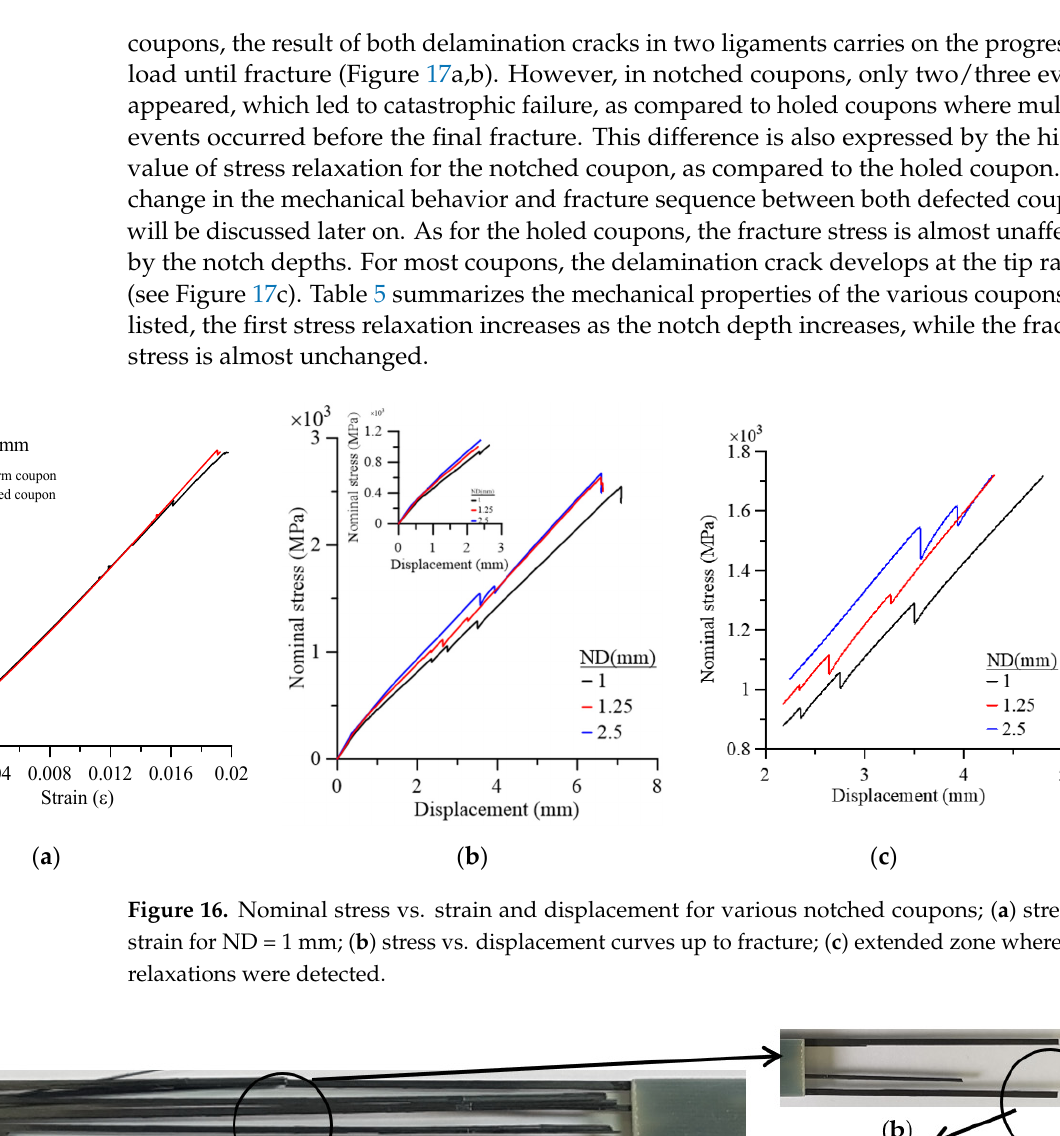
Table 5. Tensile stresses notched coupons.